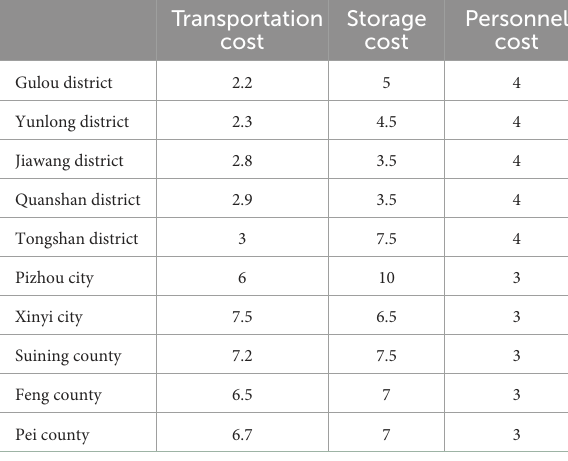
TABLE 7 Transportation cost, storage cost, and personnel cost in each region. Transportation cost